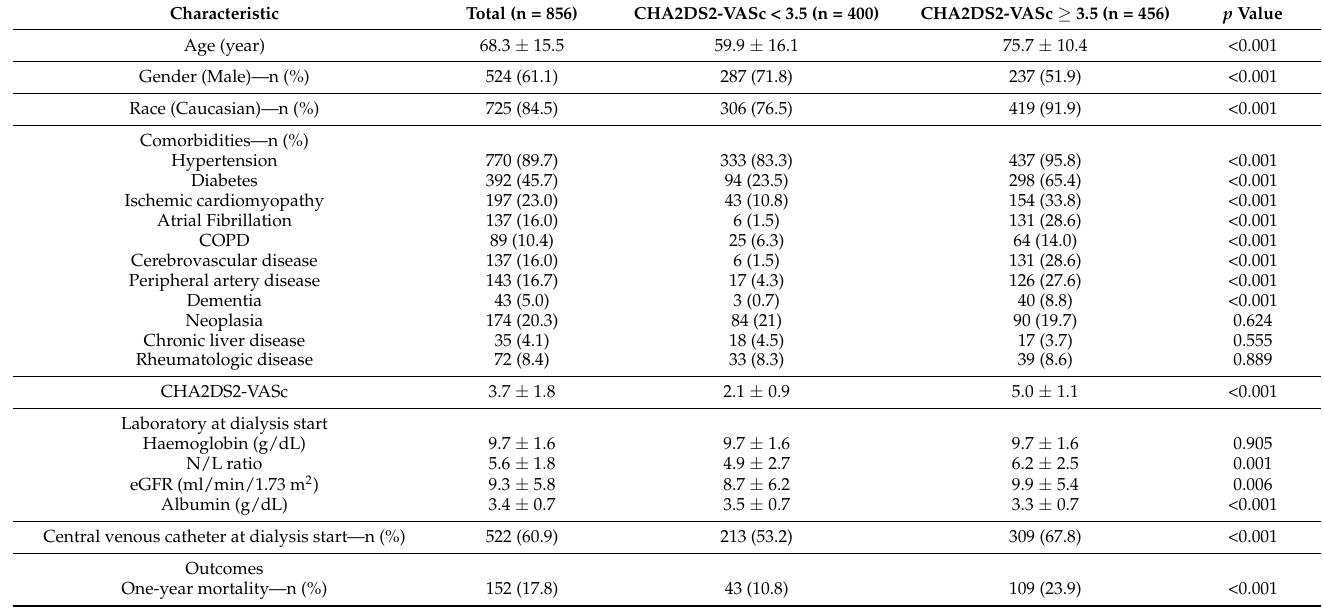
Table 2. Patient characteristics according to their CHA2DS2-VASc